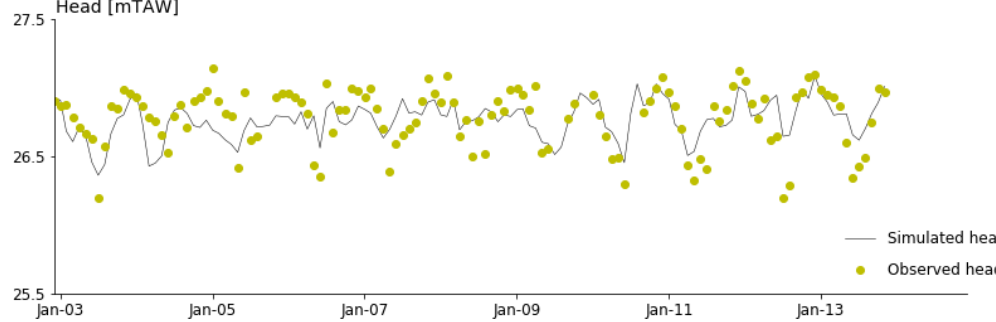
Figure 9. Temporarily varying observed and simulated groundwater head at observation well DYLP081 between 2003 and 2013.